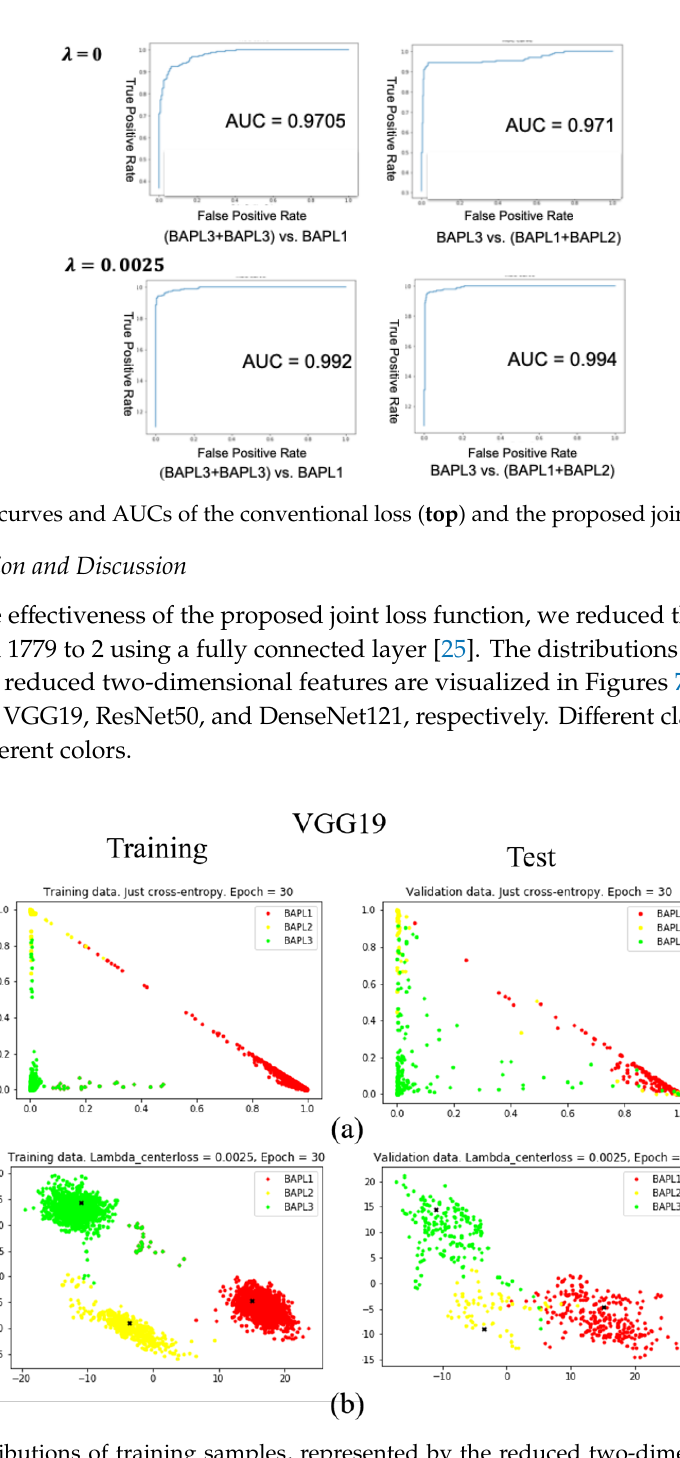
Figure 7. Distributions of training samples, represented by the reduced two-dimensional VGG19 features: ( a ) conventional loss function; ( b ) proposed joint loss function. Left: training data; right: test data.